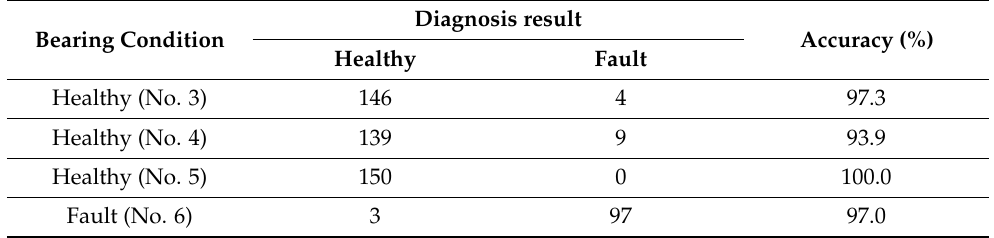
Table 2. Result of diagnosis based on SVM.